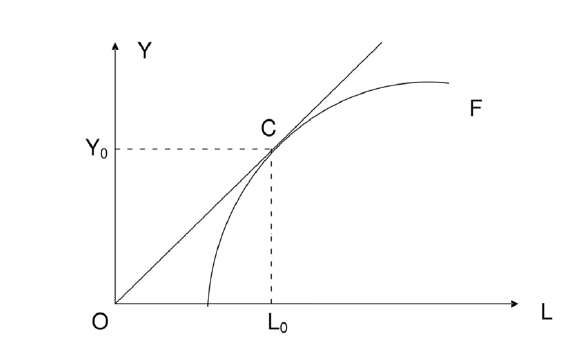
Fig. 2 Production function curve under long-term equilibrium